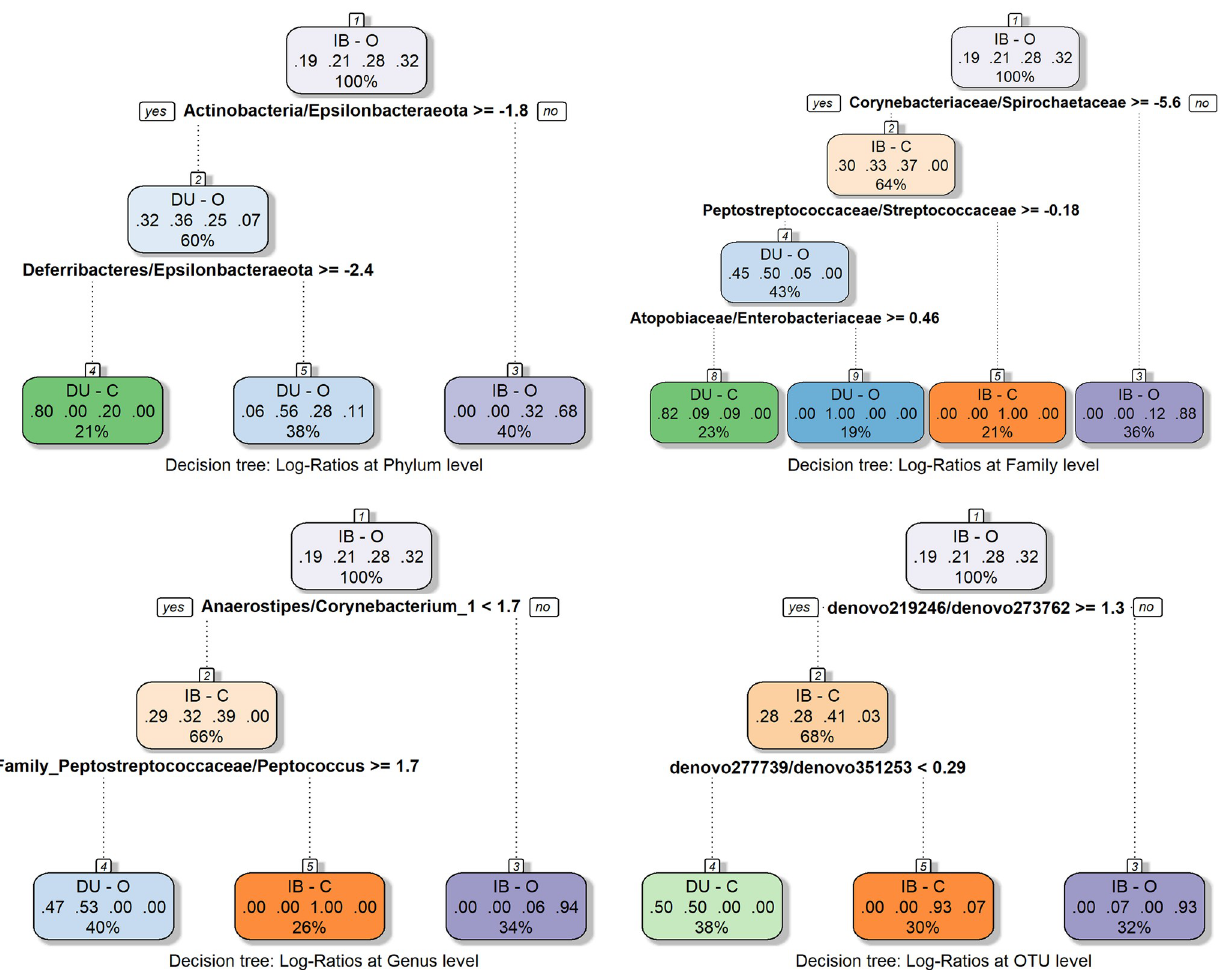
Fig 7. p-LR RPART trees. RPART trees from pairwise log-ratios at phylum, family, genus and OTU levels. Each decision level indicates the threshold value of one p-LR to classify a sample in one phenotypic group or another. Each node box displays the classification, the probability of each class at that node (i.e. the probability of the class conditioned on the node) and the percentage of observations used at that node. Class probabilities at each node are sorted as: DU-C, DU-O, IB-C and